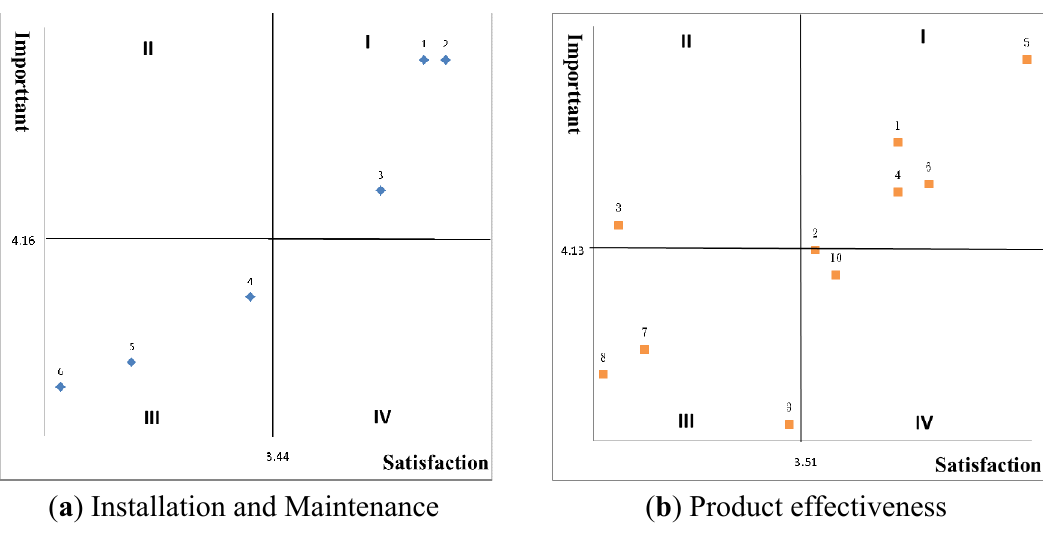
Figure 1. The results of important-satisfaction